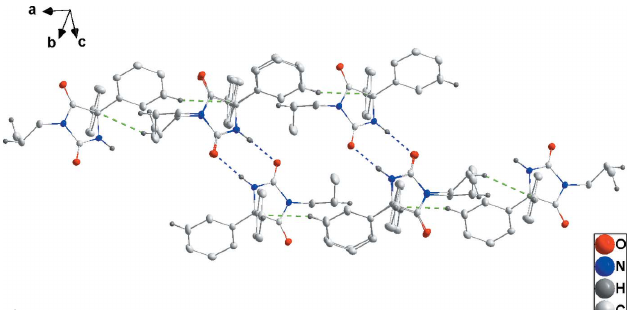
Figure 3 Edge view of two layers showing the inversion-related N—H (cid:2)(cid:2)(cid:2) O hydrogen bonds (blue dashed lines) holding them together.